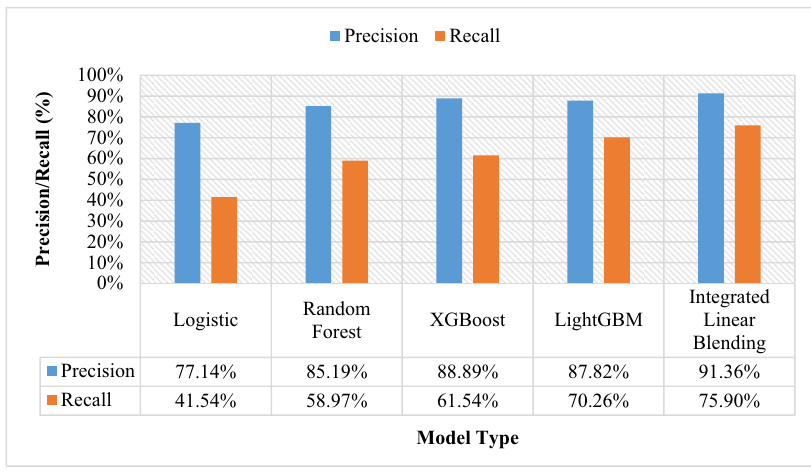
Figure 7: Comparative analysis of precision and